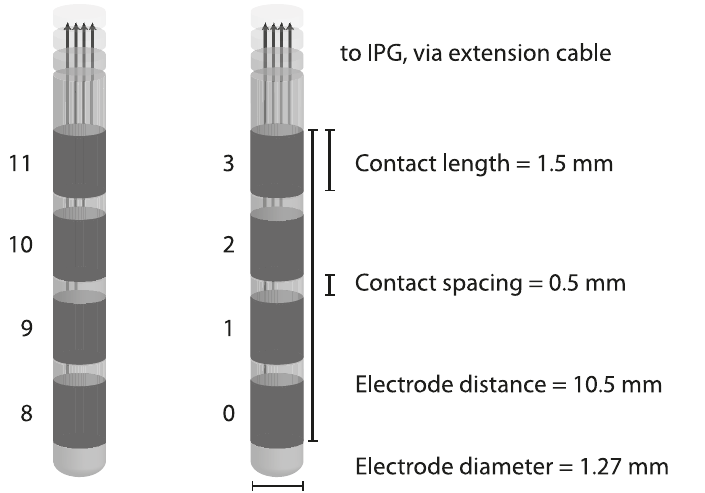
Fig 1. The Medtronic 3389 deep brain stimulation electrode studied in this work. The deepest (most distal) contacts are 0 and